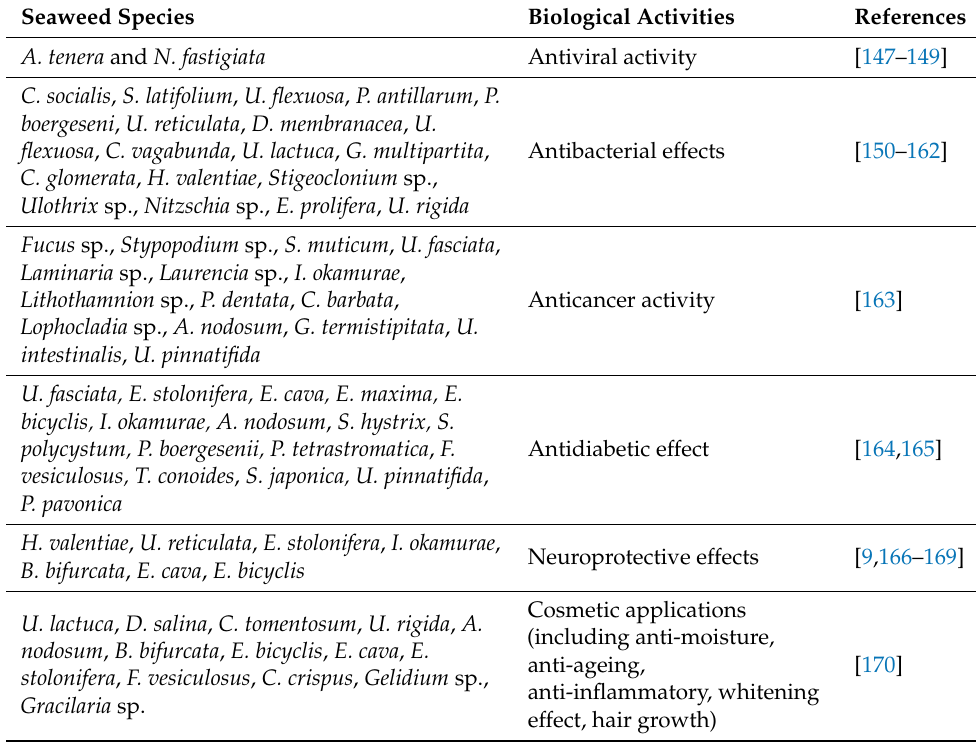
Table 4. Bioactivies of seaweeds with pharmaceutical and cosmetic